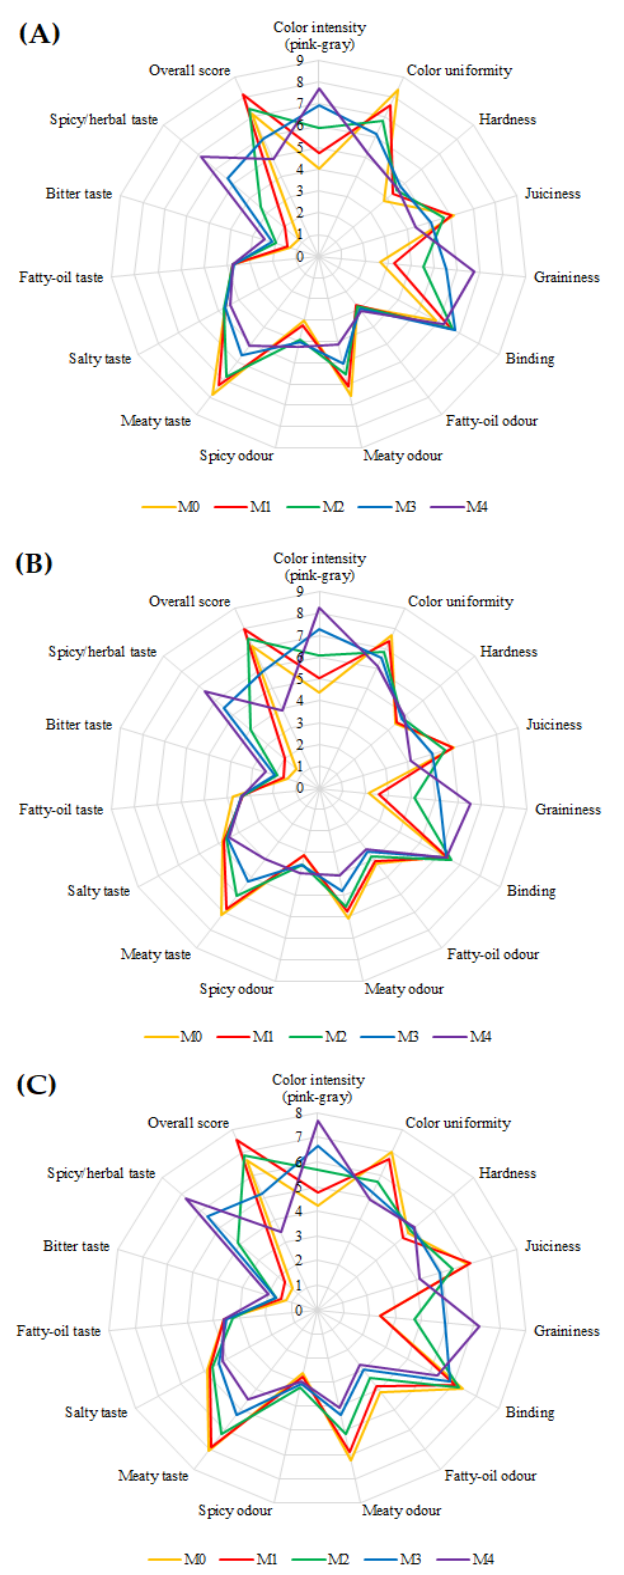
Figure 4. The spider chart represents mean sensory analysis scores for the five treatments of cooked and vacuum-packed meatballs evaluated on day 1st ( A ), 6th ( B ), and 12th ( C ) during refrigerated storage.